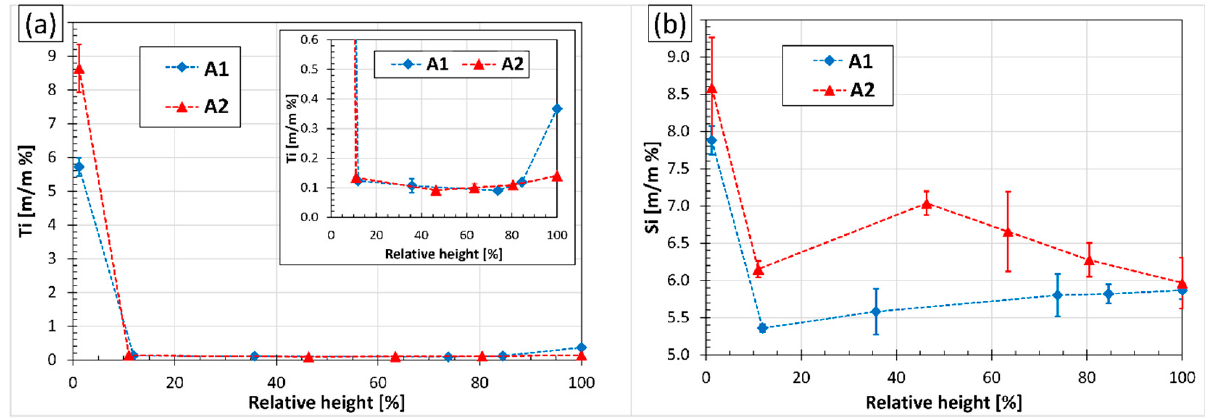
Figure 9. ( a ) Ti- and ( b ) Si-concentrations as a function of relative height in the samples solidified in the crucible during the experiments.